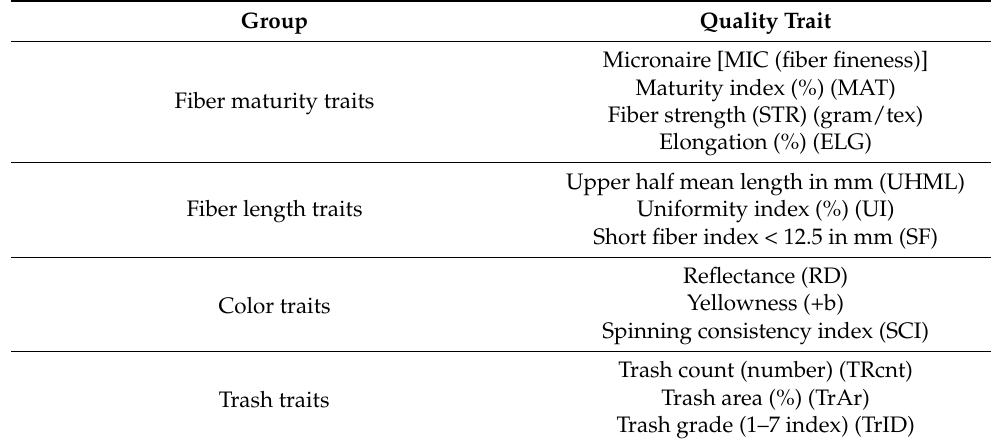
Table 1. The thirteen evaluated cotton quality traits divided in four groups: (a) fiber maturity; (b) fiber length; (c) color; and (d) trash traits.